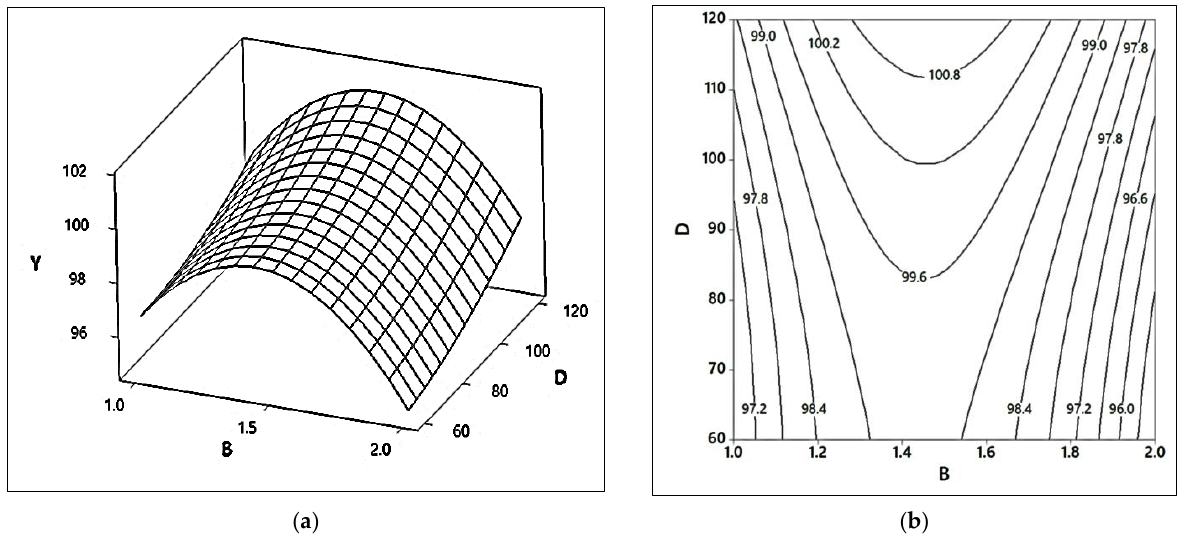
Figure 13. Interaction effect of the NaOH catalyst content (A) and reaction time period (D) on the FAME yield (Y) of the transesterification process. ( a ) A 3D response surface plot of Y (%) vs. B (wt.%) and D (minutes). ( b ) A 2D contour plot between A and D.